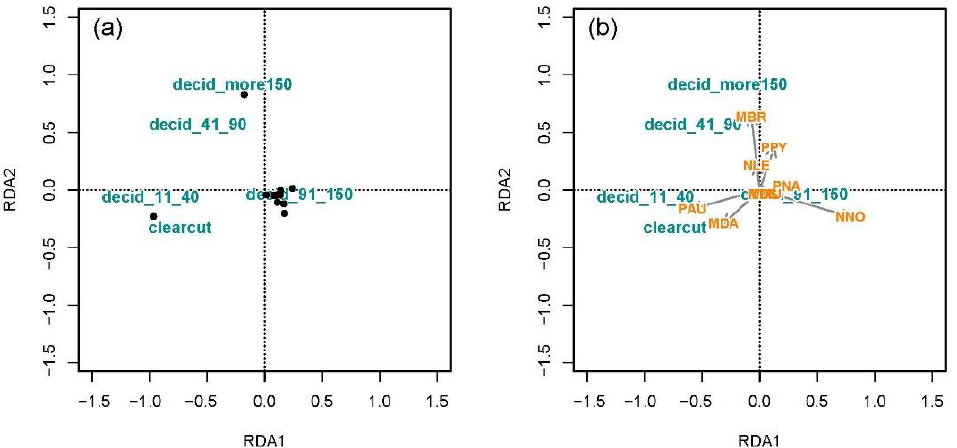
Figure 6. Results of redundancy analysis revealing the relationship between the forest age and assemblage structure at the plot level. ( a ) Overlay of samples (at each plot) and forest age classes shown in green–blue: clearcut, decid_11_40, decid_41_90, decid_91_150, decid_more150. ( b ) Overlay of species shown with gray arrows and orange 3-letter species abbreviations and forest age classes shown in green–blue.